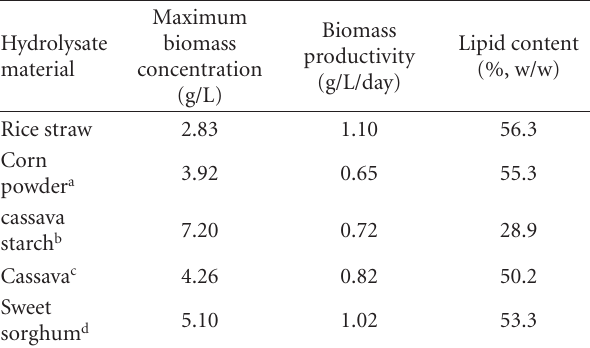
Table 2: Comparison of maximum biomass concentration, biomass productivity, and lipid content of Chlorella strains growing in di ff erent hydrolysate